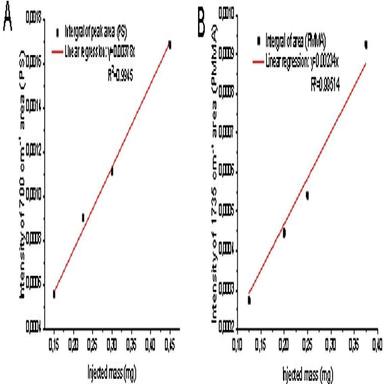
Calibration of ThFFF-FTIR. Four concentrations of each homopolymer were used to obtain four signal intensities. Linear regression is applied to obtain the slope for (A) PS at 700 cm−1 (B) PMMA at 1735 cm−1.